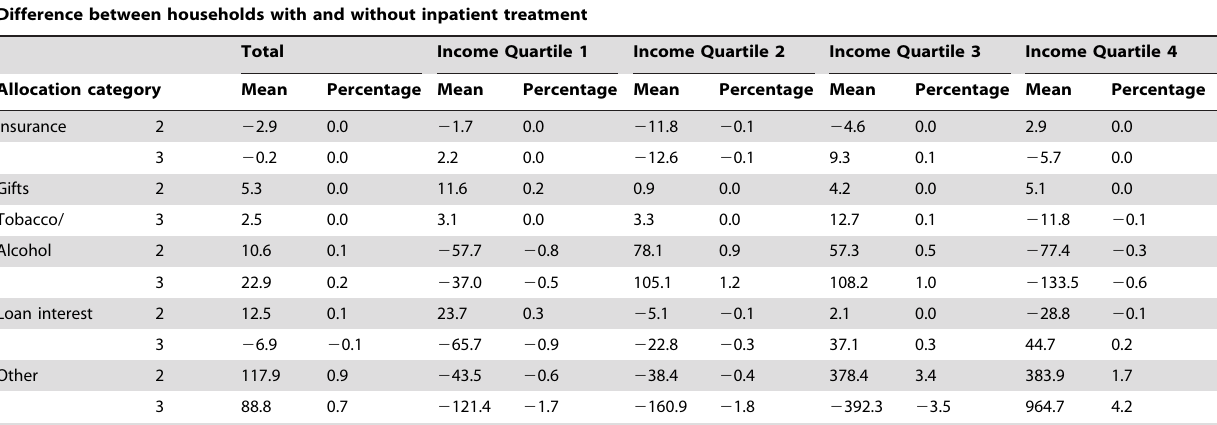
INPATIENT TREATMENT Difference between households with and without inpatient treatment